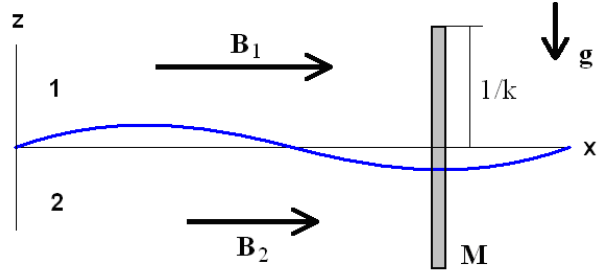
Fig. 4. A schematic to explanation of the interchange instability in magnetized plasma. The numbers 1 and 2 are related to the heavier and lighter fluids, respectively. The undisturbed boundary between two fluids is in the x–y plane; g is the effective gravitational accel- eration, M is the mass of a fluid element with the half-height 1 /k where k is the wave number. B 1 and B 2 are the magnetic fields in two media. The instability develops better when the k -vector is directed across the magnetic field as in Fig.